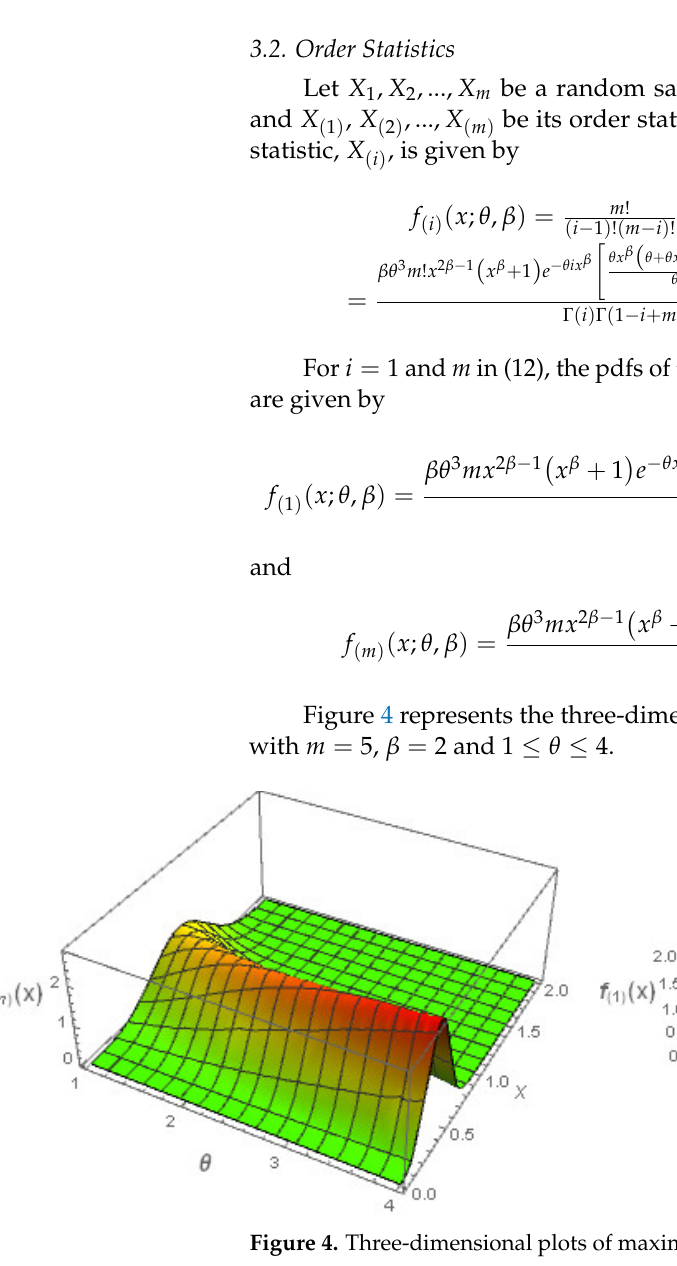
Figure 4. Three-dimensional plots of maximum and minimum pdf of the PZD for 5, 2 m .